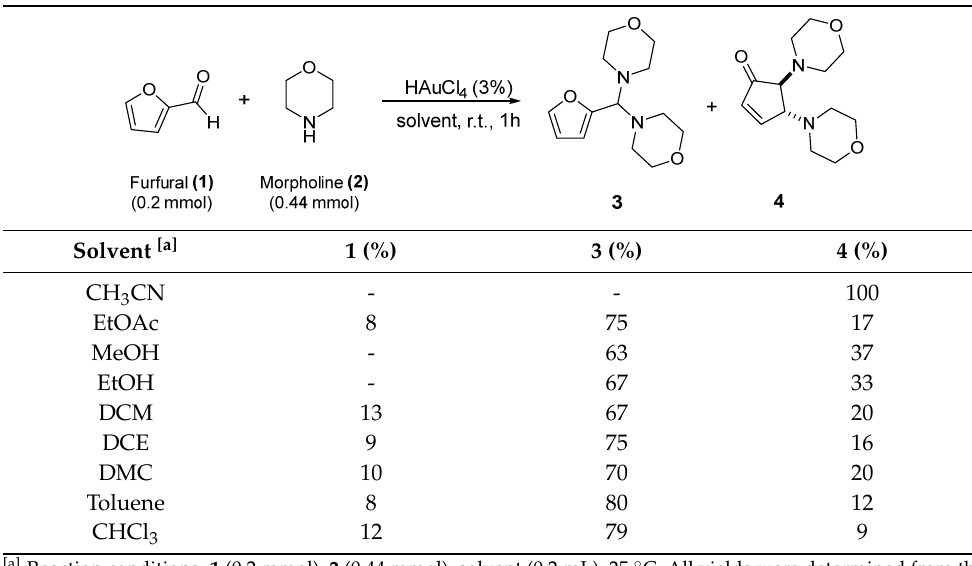
Table 1. Solvent screening in the presence of HAuCl 4 .